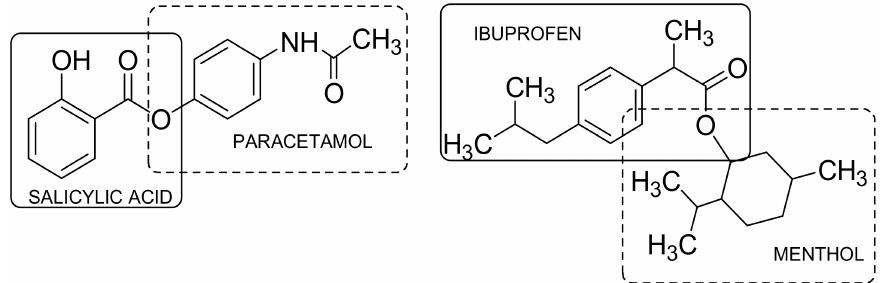
Figure 6. Direct